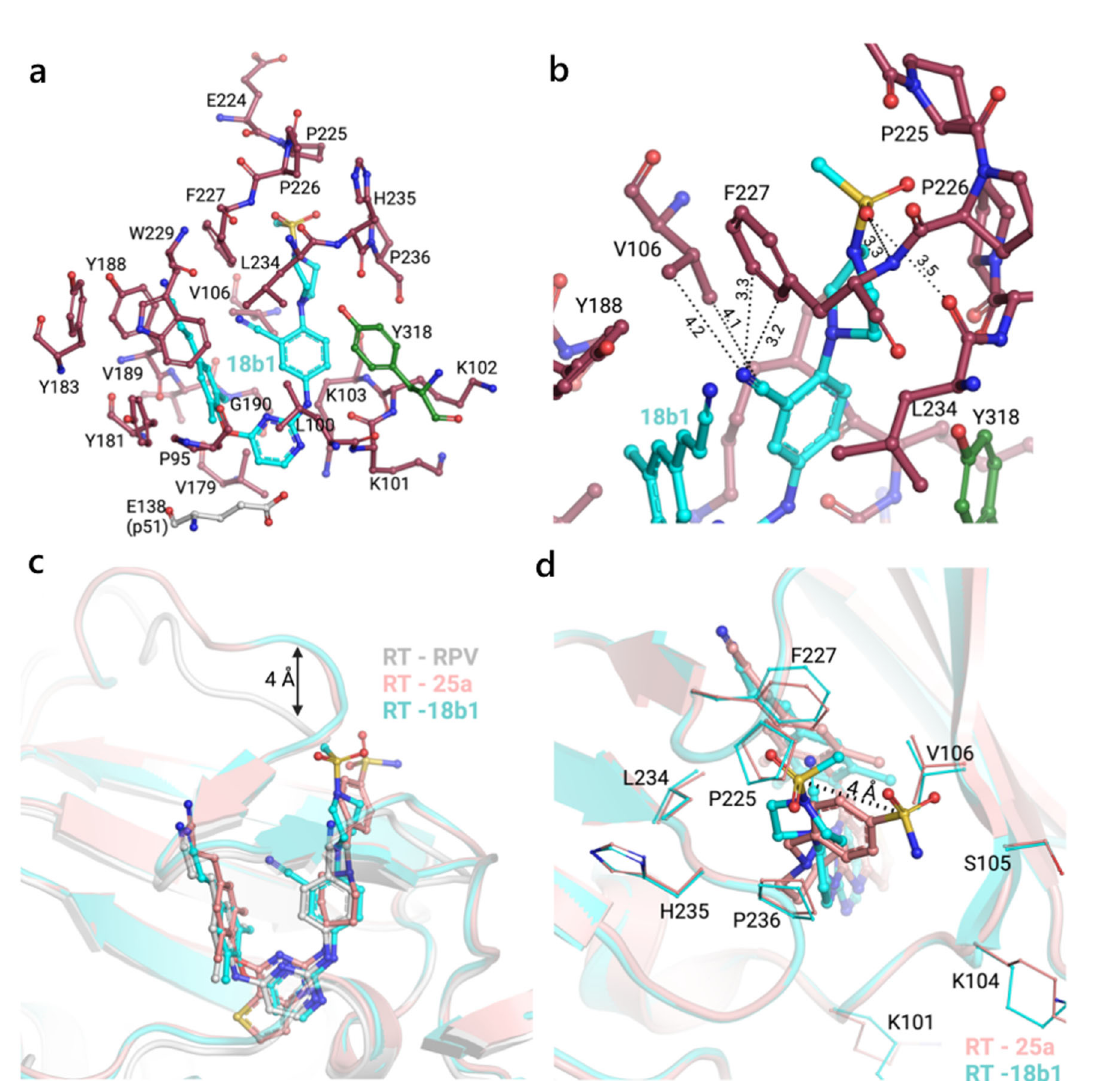
Fig. 5 Crystal structure of HIV-1 RT in complex with 18b1 (PDB ID: 8FE8). a 18b1 binding in the NNIBP. Color legend: (i) RT p66 subdomains: palm in dark red, thumb in green; (ii) RT p51 subunit in silver. b 18b1 cyano and sulfonyl groups contacts with RT. c Comparison of the RT complexes with RPV (PDB 4G1Q) and 25a (PDB 6C0N). d Comparison of the piperazine sulfonyl moiety positioning in the RT complexes with 18b1 and 25a (PDB 6C0N). Created with PyMOL (http://www.pymol.org/) and with